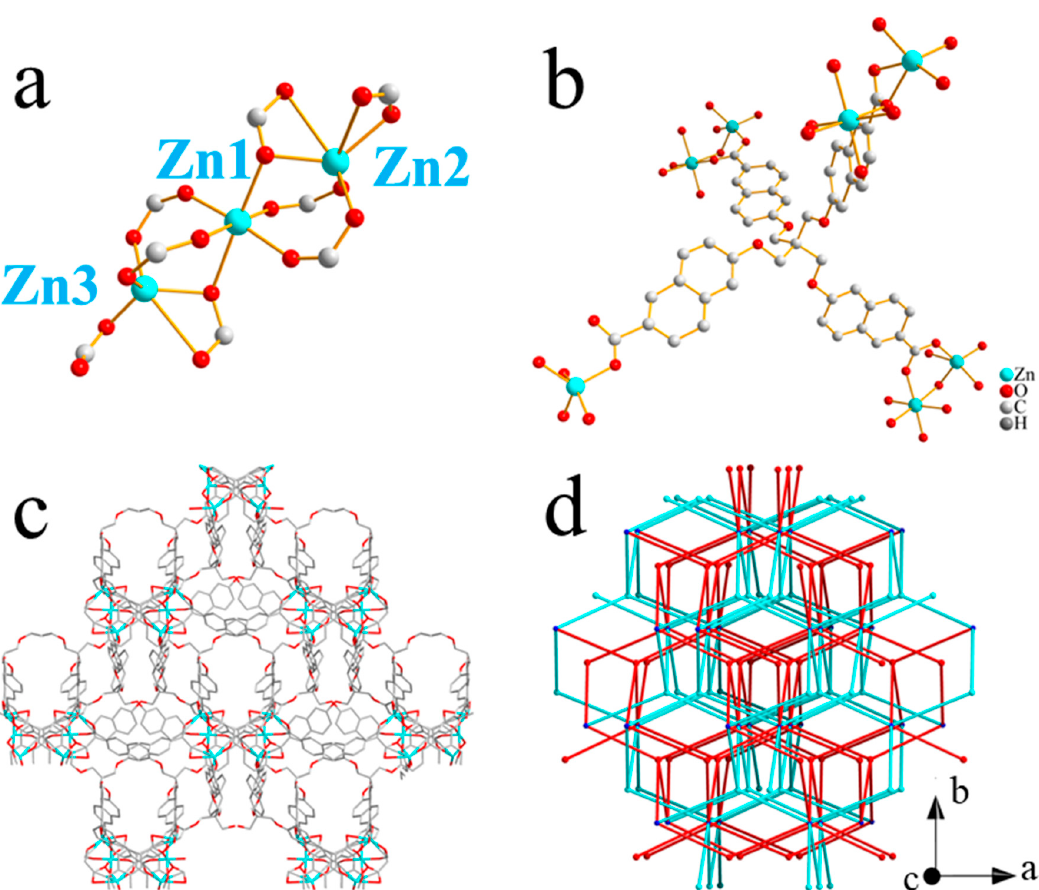
Figure 1. Coordination environment of ( a ) Zn and ( b ) ligand. ( c ) one-dimensional channel along c -axis with size of 3.41 × 5.17 Å 2 . ( d ) Simplified topology; blue and red represent two independent interpenetrated frameworks.